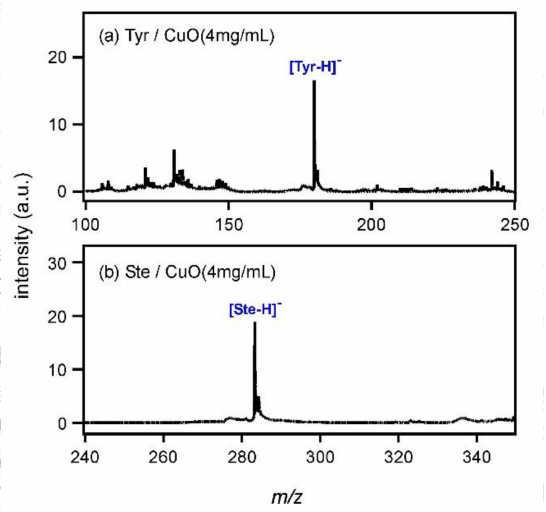
Figure 3. Mass spectra of ( a ) tyrosine (Tyr) and ( b ) stearic acid (Ste) with CuO nanoparticles as matrix (4